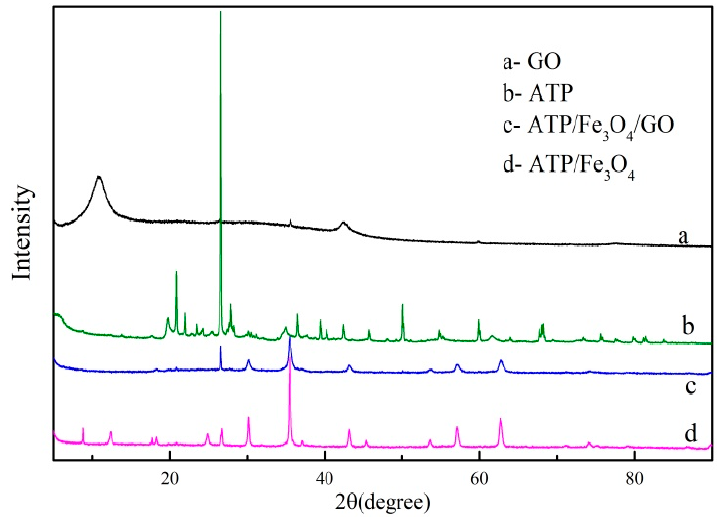
Figure 3. The X-ray diffraction patterns of GO, ATP, ATP/Fe 3 O 4 , and ATP/Fe 3 O 4 /GO.